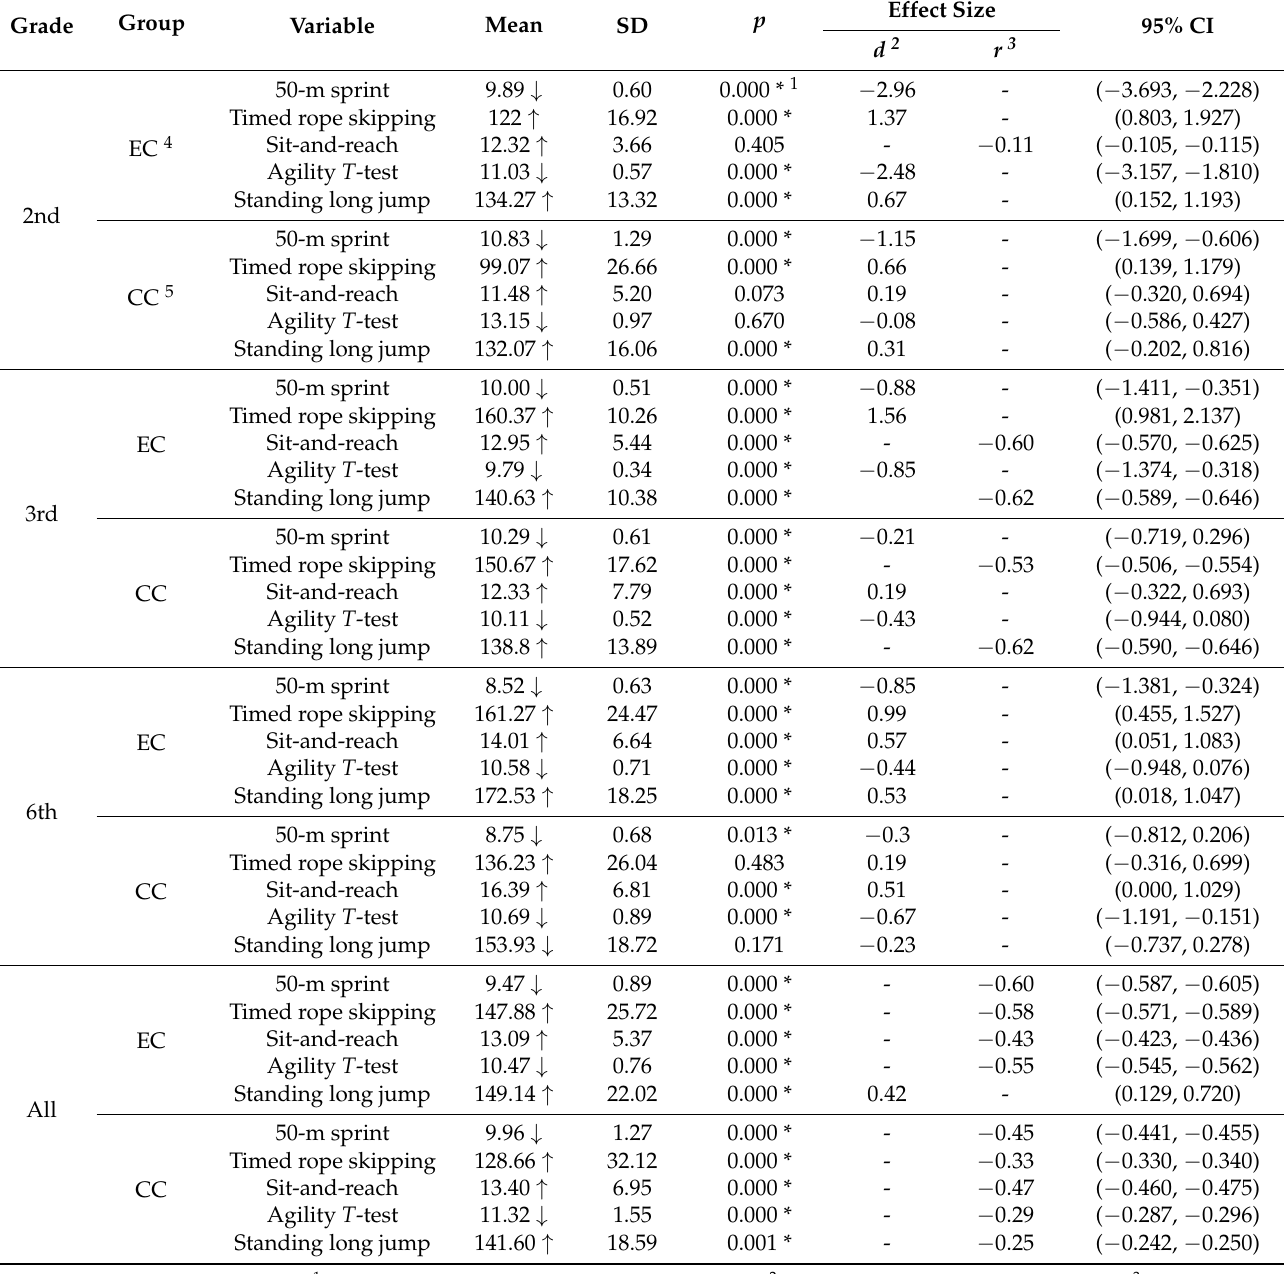
Table 4. Within-group changes by grade after the intervention.